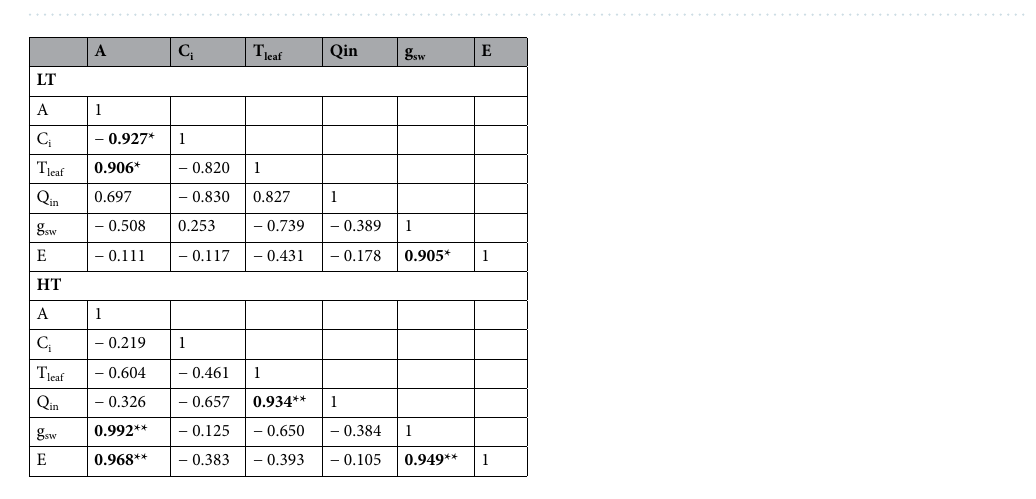
Figure 3. Diurnal changes in Fv’/Fm’ and ETR under different temperatures. Fv’/Fm’: effective photochemical quantum yield and ETR: electron transfer rate.